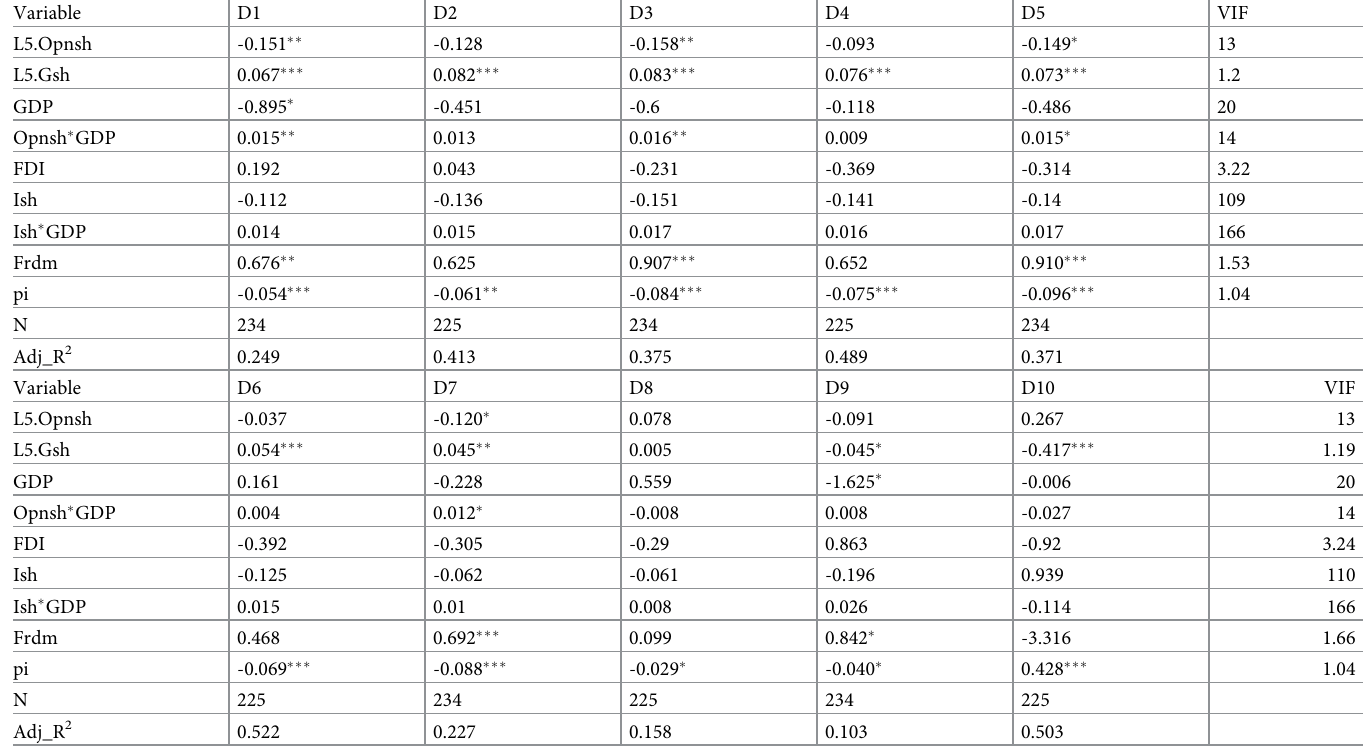
Table 10. Replication of Milanovic